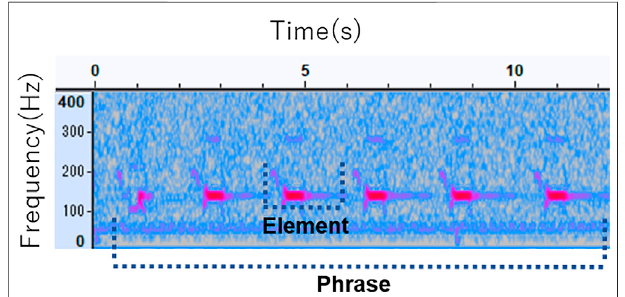
FIGURE 1 | Structure of Eurasian Bittern ’ s